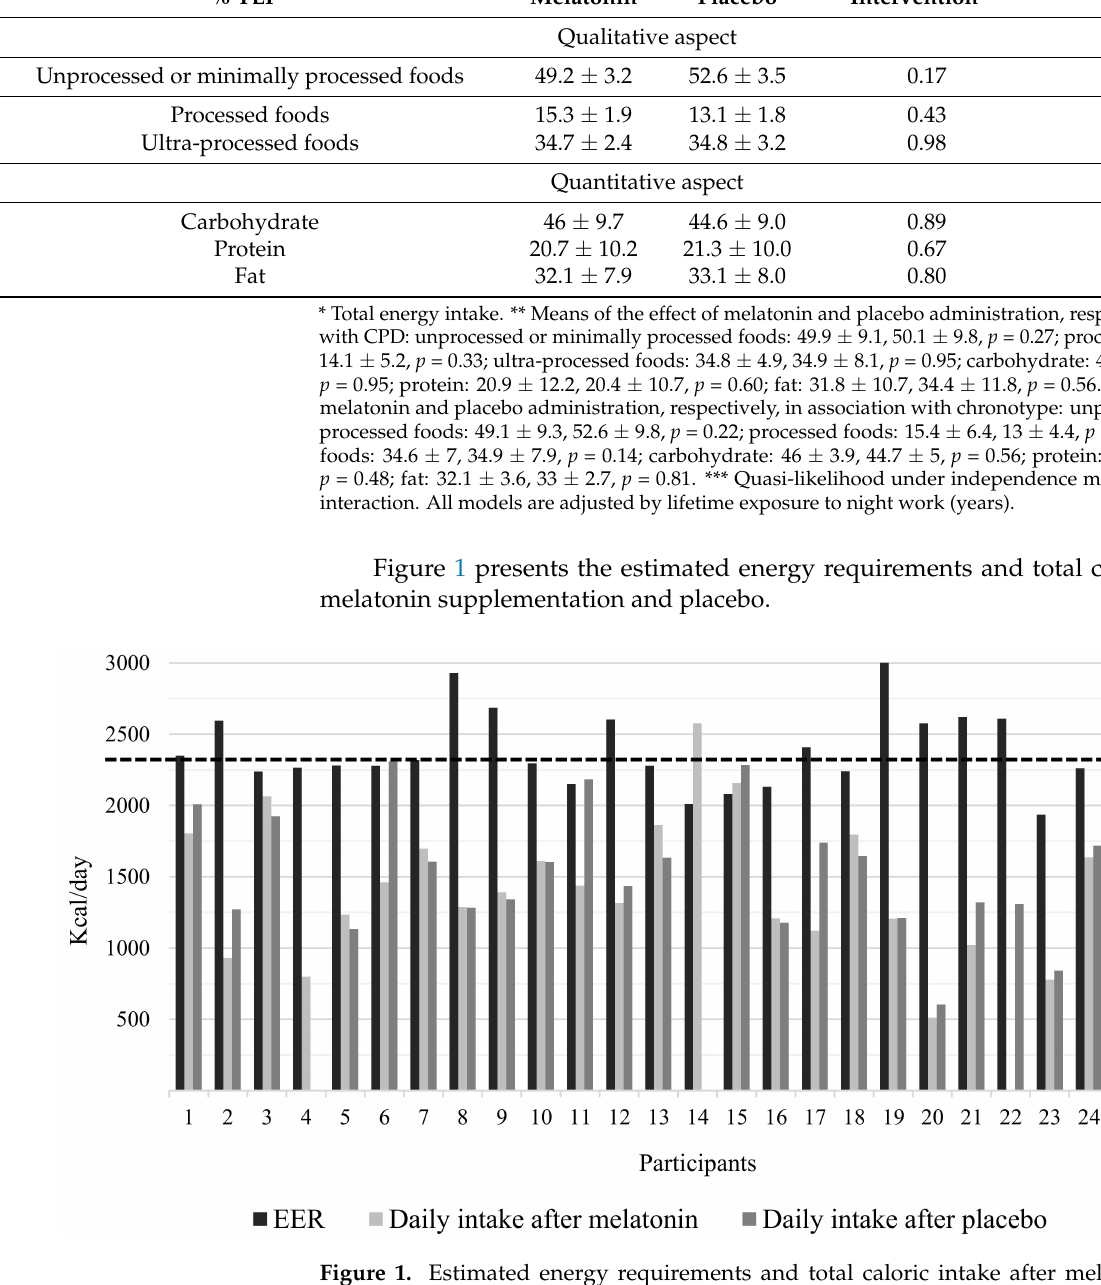
Figure 1. Estimated energy requirements and total caloric intake after melatonin and placebo administration. EER: estimated energy requirement. The dashed line represents the mean EER (kcal/day) of the participants. No food intake was recorded in the diaries after placebo administration for participants 4 and 14, and after melatonin administration for participant